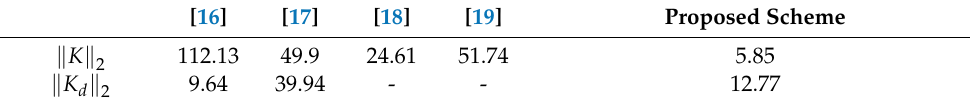
Table 5. Comparison of the gain matrices norm values of the